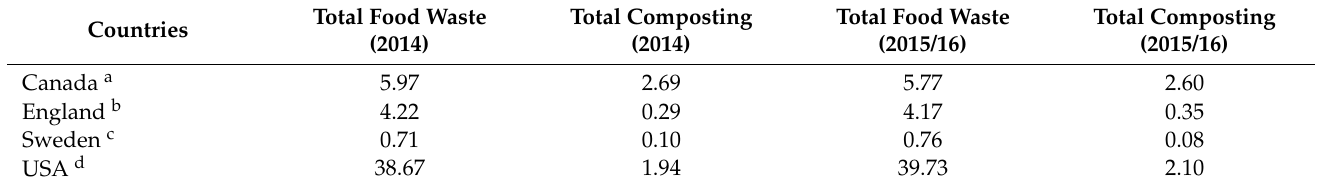
Table 1. Composting data with respect to the total food waste for four nations (Mega Tonnes).